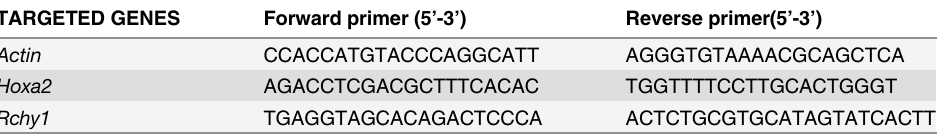
Table 2. Primers used for RT-PCR